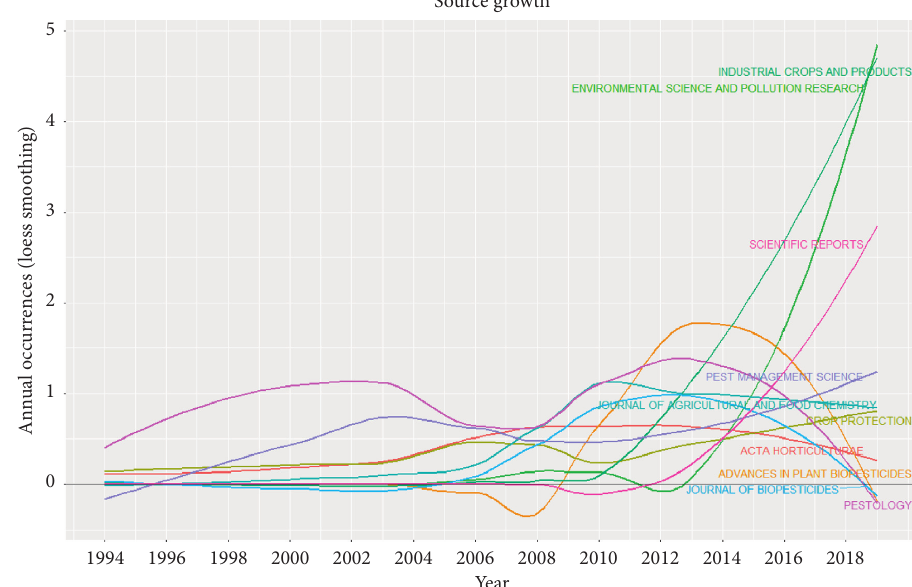
Figure 5: Source growth of the top 10 most productive journals from 1994 to